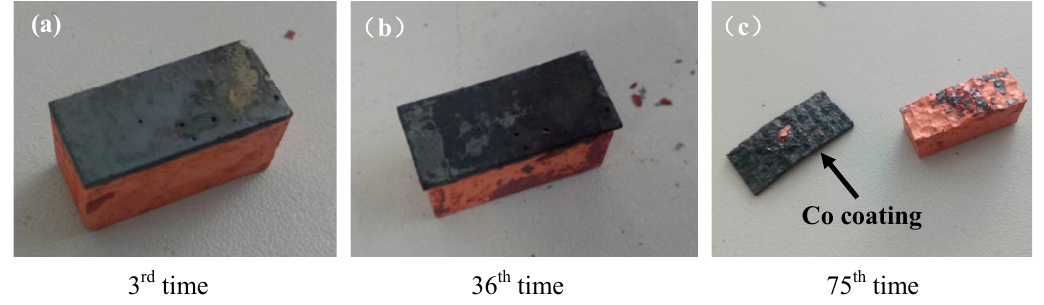
Figure 9. Macro morphology of the sample after the 3 rd ( a ), 36 th ( b ), and 75 th ( c ) experiments of heat shock resistance.